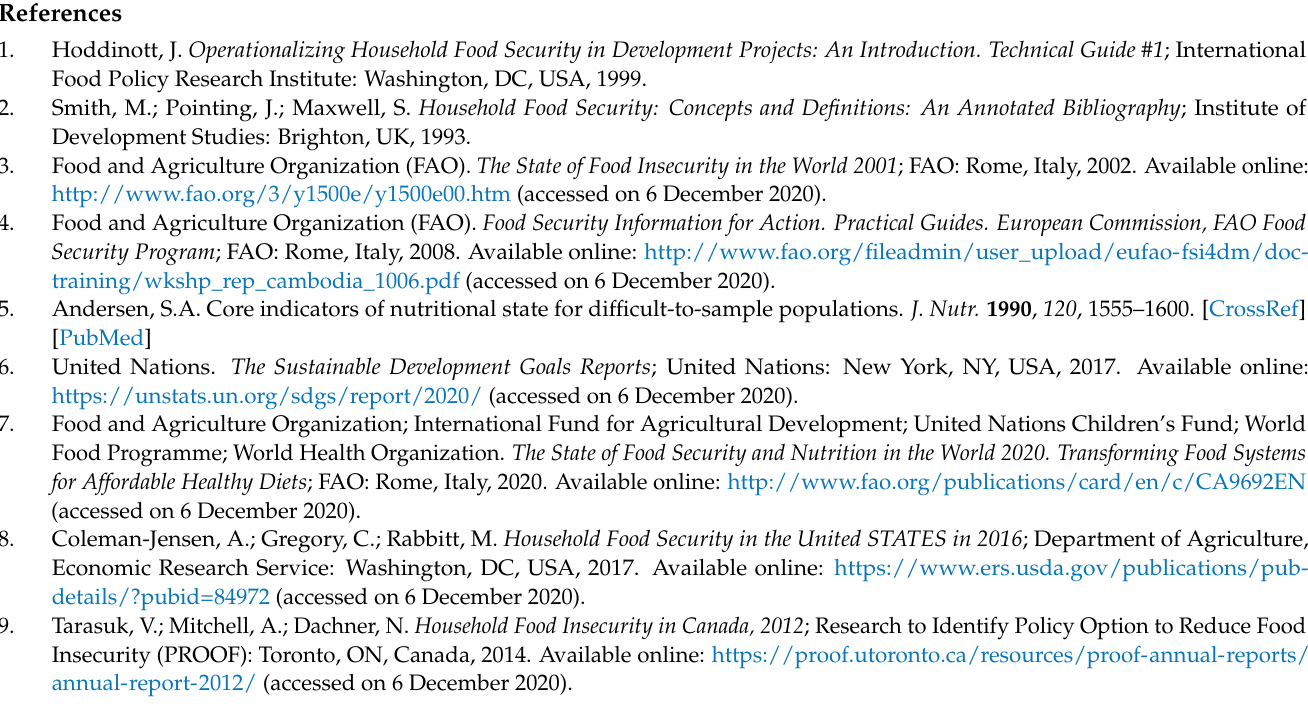
studies. Table S2: Studies that met the criteria of the checklist for qualitative